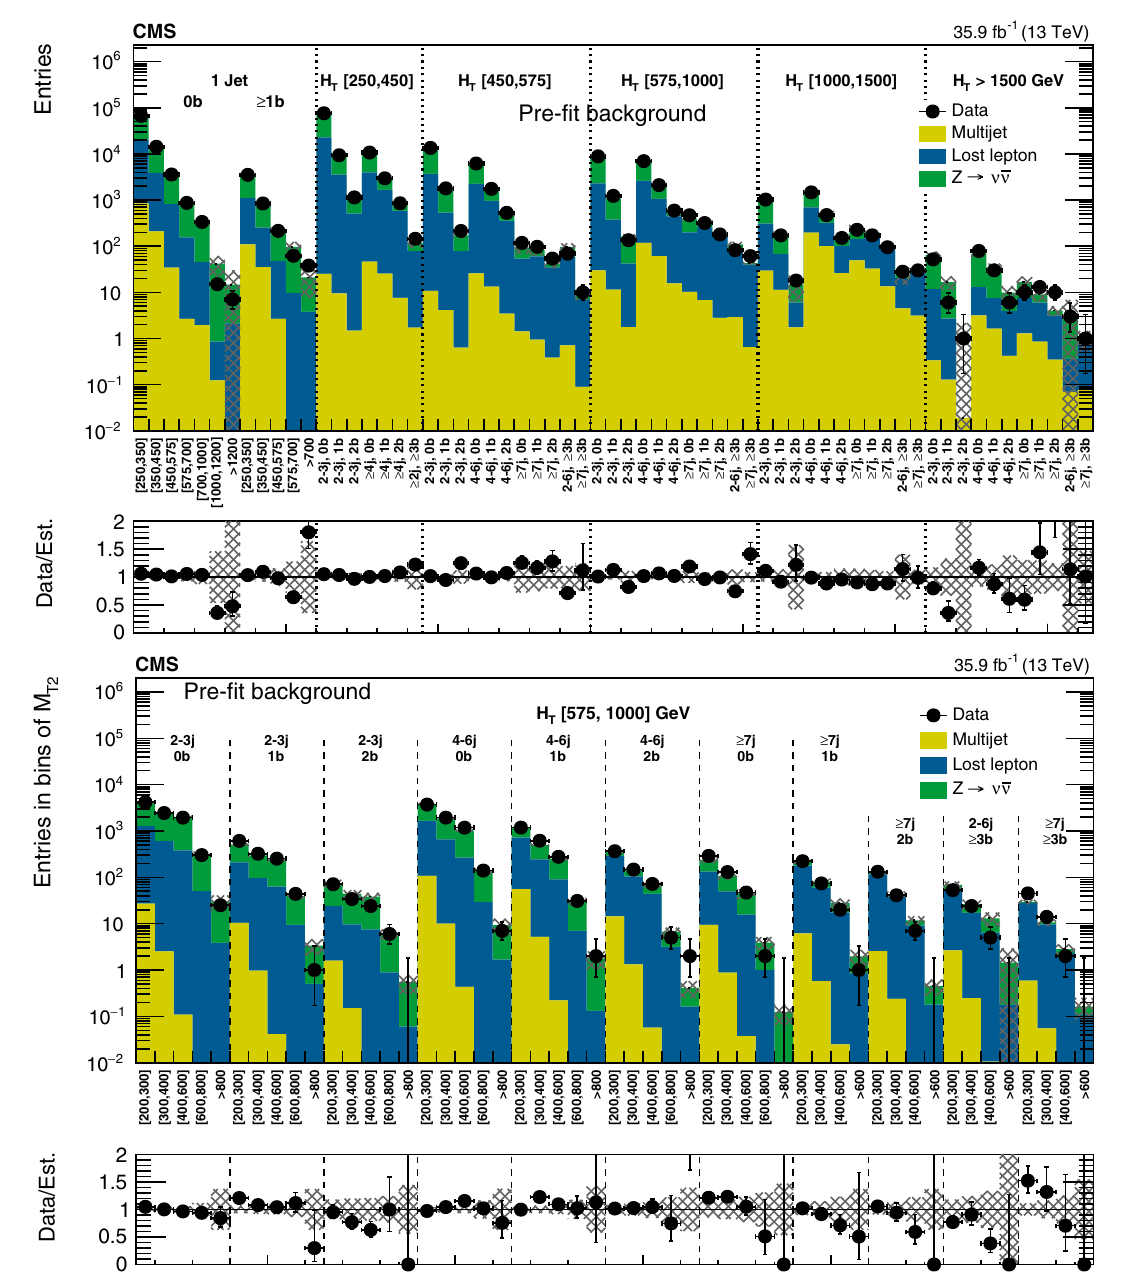
Fig. 4 (Upper) Comparison of estimated (pre-fit) background and observed data events in each topological region. Hatched bands repre- sent the full uncertainty in the background estimate. The results shown for N j = 1 correspond to the monojet search regions binned in jet p T ,